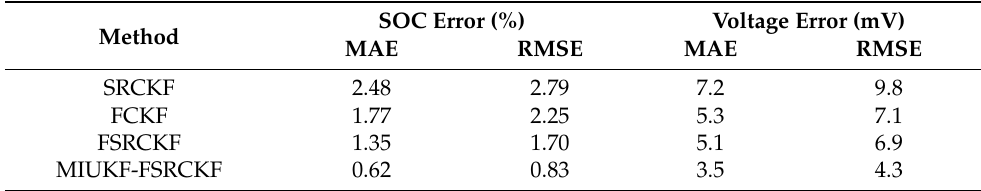
Table 7. SOC error and voltage error of each algorithm under BJDST. (The identified R 0 by AGA is increased by 20% as the initial value of R 0